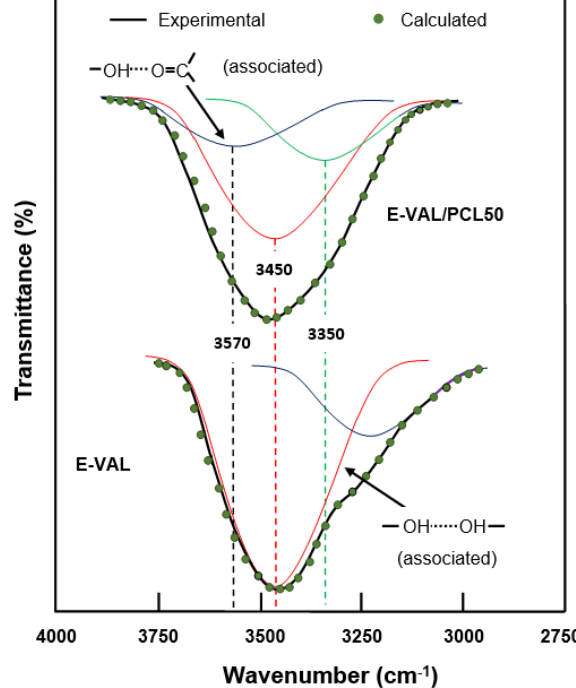
Figure 4. Deconvolution of the absorption band between 3000 and 3750 cm − 1 in free and associated hydroxyl peaks of pure E-VAL and the E-VAL/PCL50 blend.